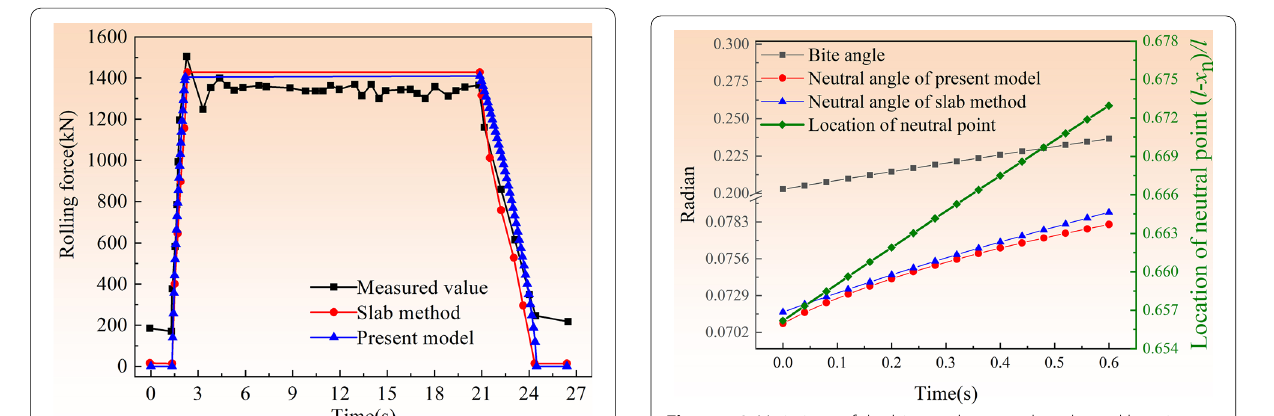
Figure 10 Variations of the bite angle, neutral angle, and location neutral points in downward